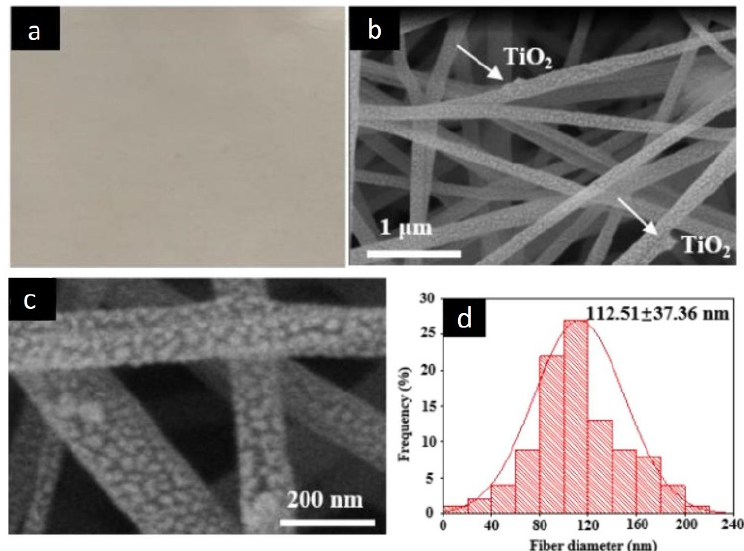
Figure 17. Optical imaging ( a ), typical SEM ( b ), FESEM image ( c ), and histogram ( d ), of PAN/B- cyclodextrin/TiO 2 /GOv with TiO 2 :GO 9:1 nanofiber diameter distribution. (Adapted from the work of Zhang et al. [48]. Copyright 2021, with permission from